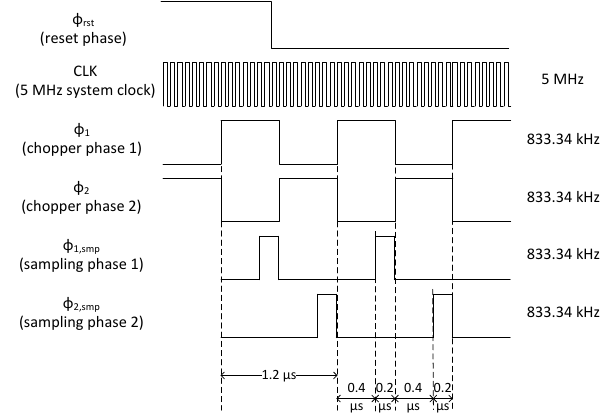
Figure 2. Clocking scheme for chopper and demodulator.